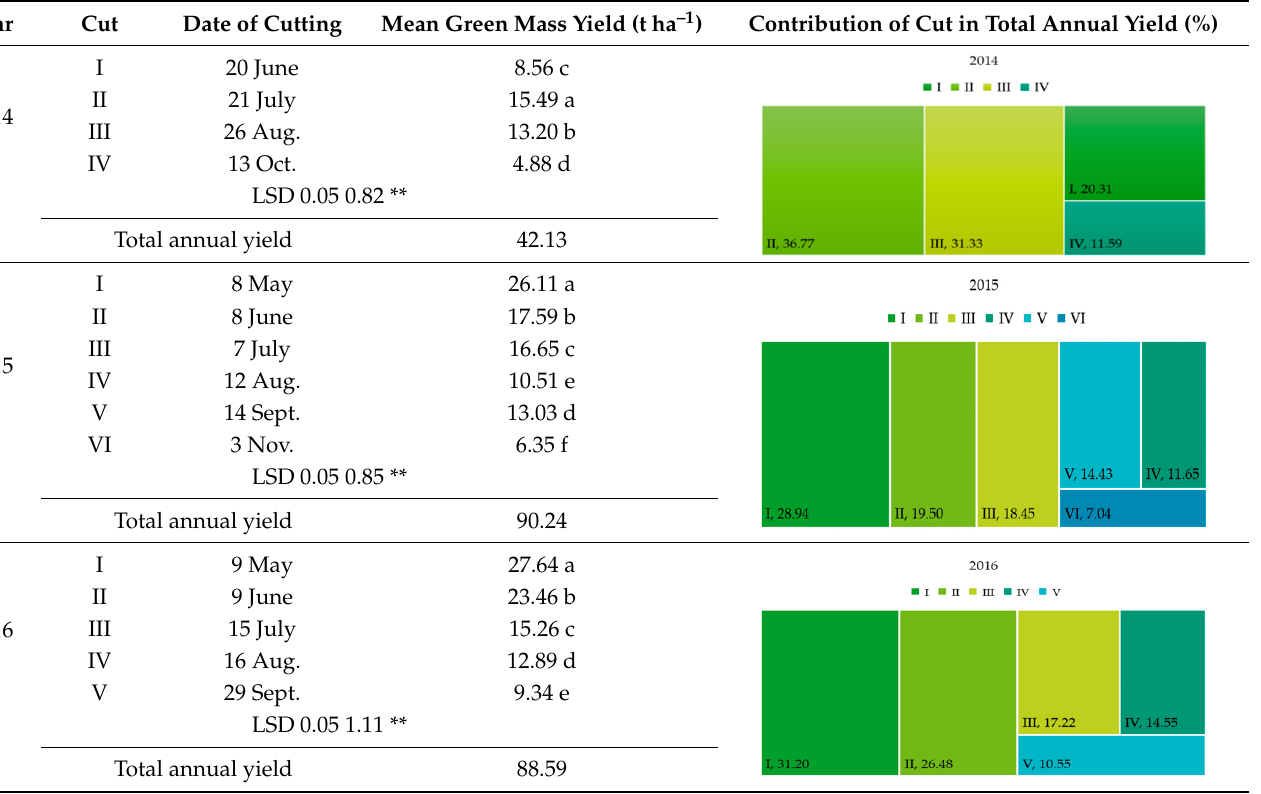
Table 3. Mean green mass yield of all alfalfa experimental populations/cultivar per cuttings during 2014–2016.